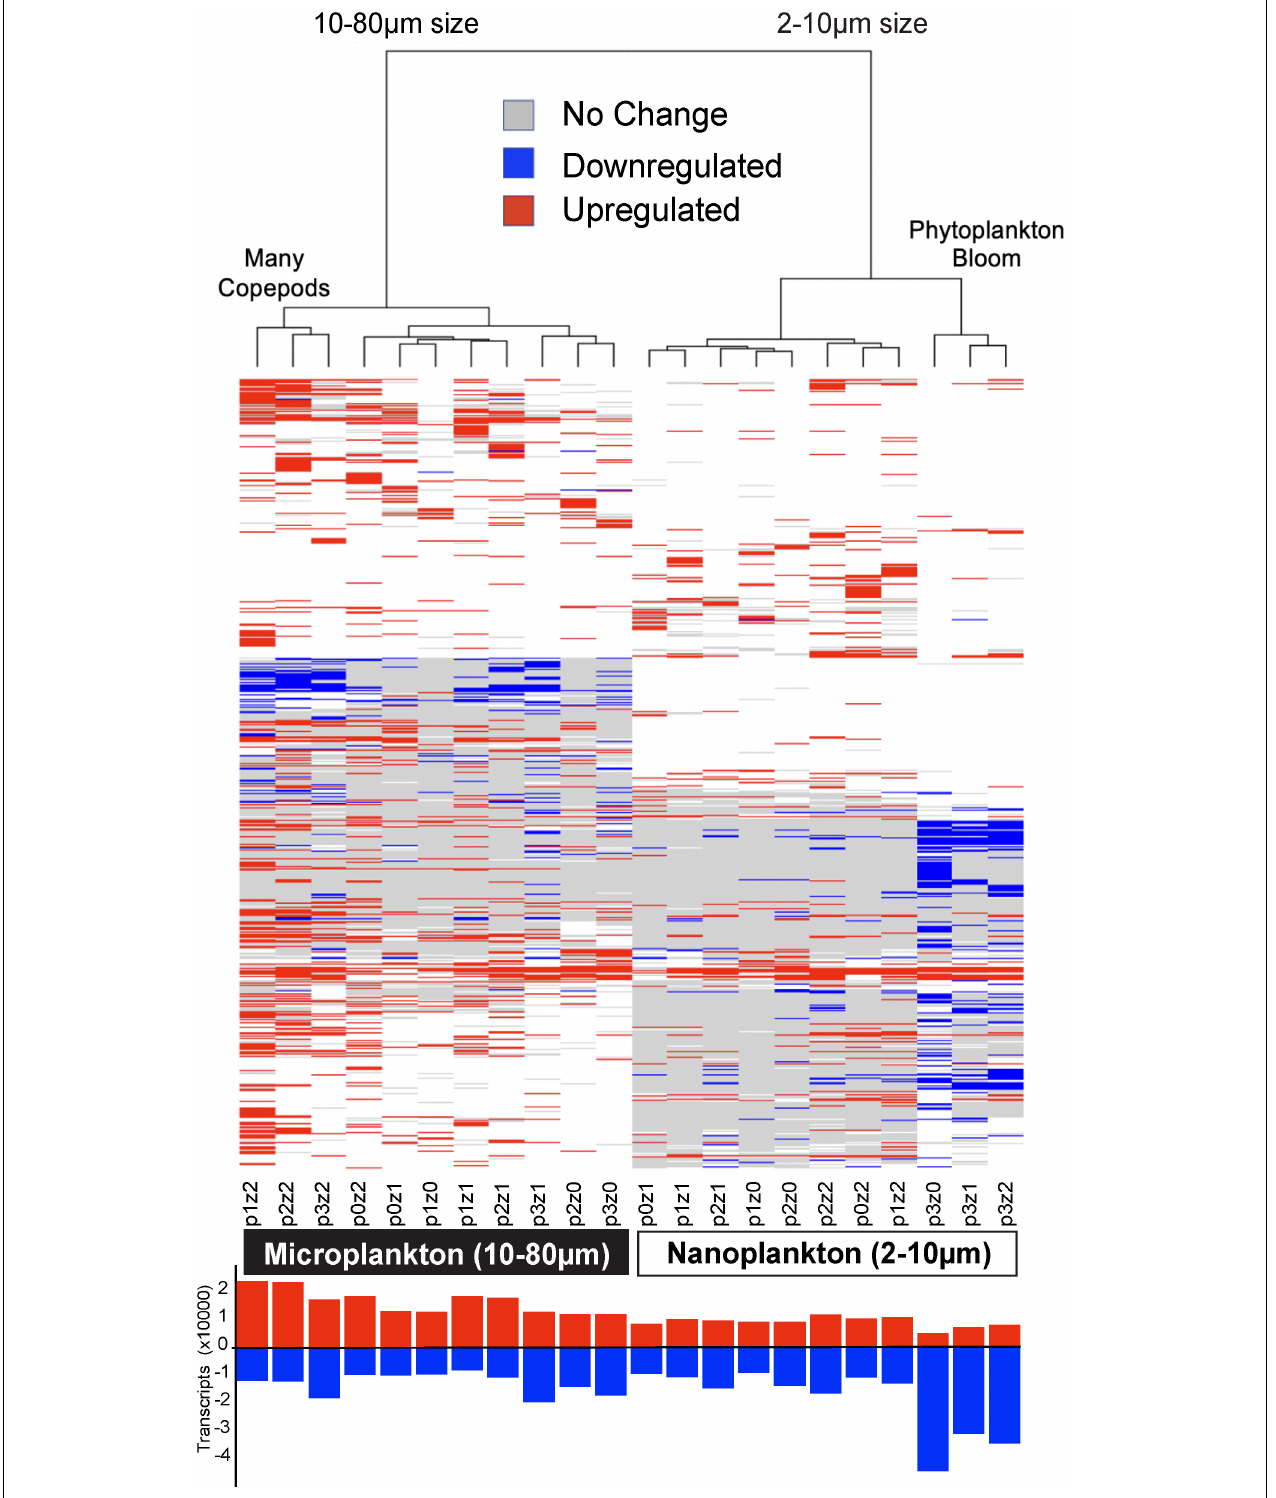
FIGURE 4 | Heatmap of differential gene expression for each of the 81,634 transcripts matching gene families (rows) across treatments (columns). The highest downregulation was in nanosized communities in phytoplankton bloom conditions, while the greatest upregulation was in microplankton with the most copepods. The clustering of the samples is based on Euclidean distance and WardD algorithm. The bar graph at the bottom shows the number of transcripts up or down-regulated (absolute difference to the control higher than log2). See Figure 1 for details about sample labels.